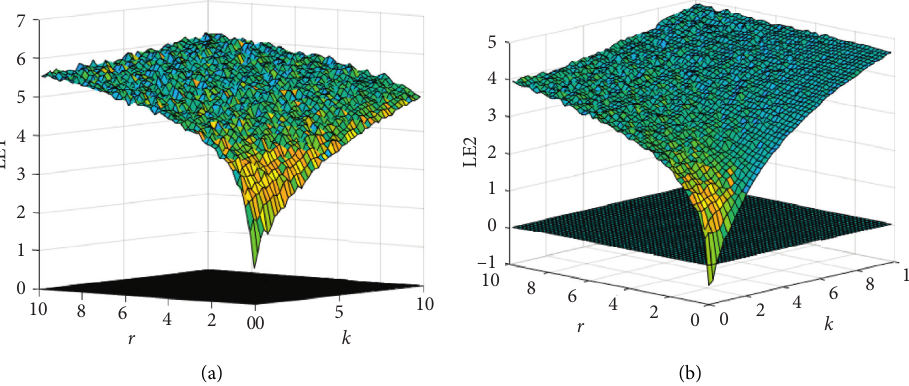
Figure 2: Lyapunov exponent diagrams by varying parameters k,r ∈ ( 0 , 10 ]